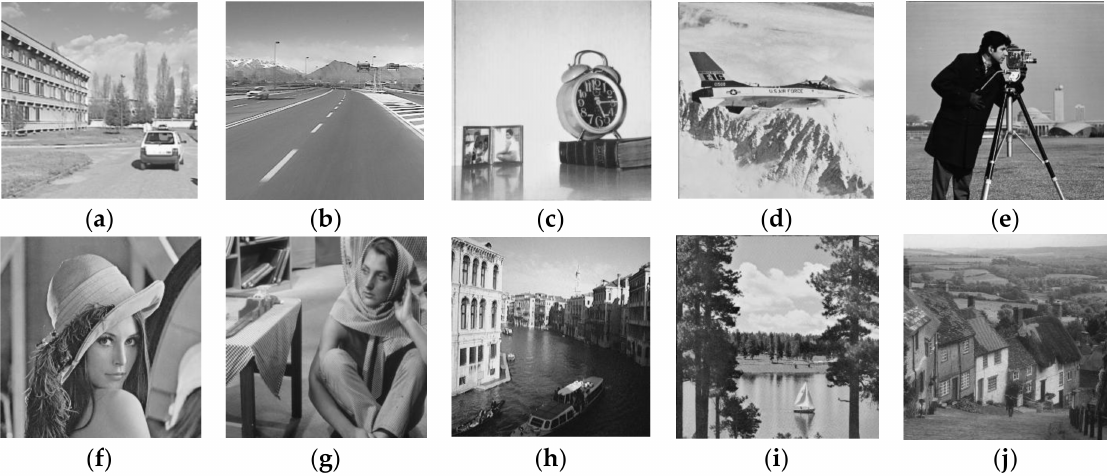
Figure 5. Test images: ( a ) Car1; ( b ) Car2; ( c ) Clock; ( d ) Airplane; ( e ) Cameraman; ( f ) Lena; ( g ) Barbara; ( h ) Venice; ( i ) Boat; ( j )